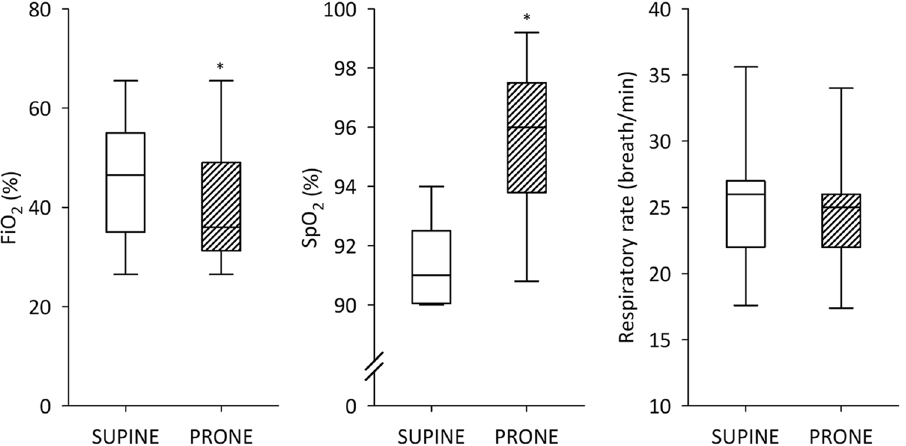
Figure 3. Fraction of inspired oxygen (FiO 2 ), oxygen saturation (SpO 2 ), and respiratory rate for noninvasively ventilated patients in supine and prone position. Empty boxes indicate data acquired from the prone position; boxes with diagonal line pattern indicate data from the supine position. *: p < 0.05 versus supine position.